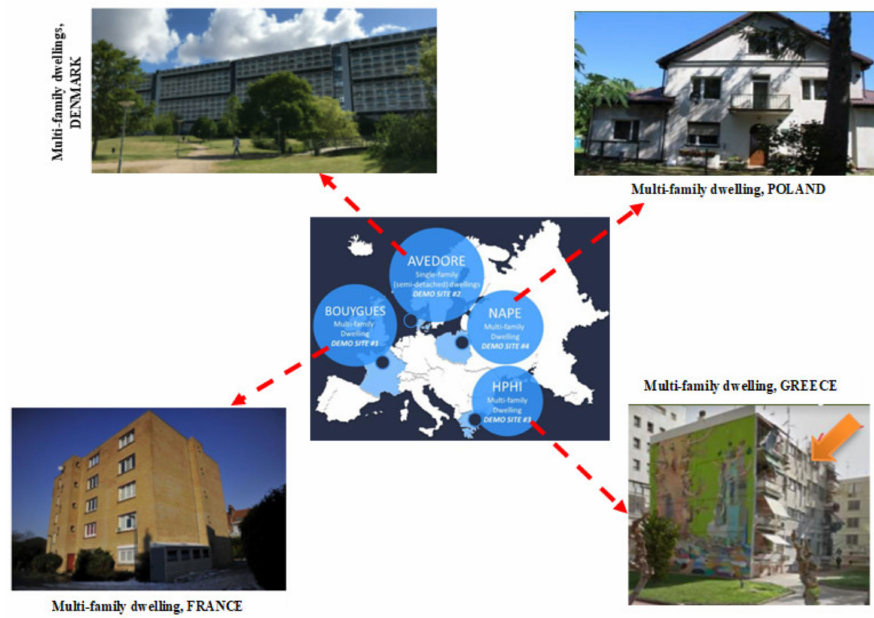
Figure 17. RINNO Demo